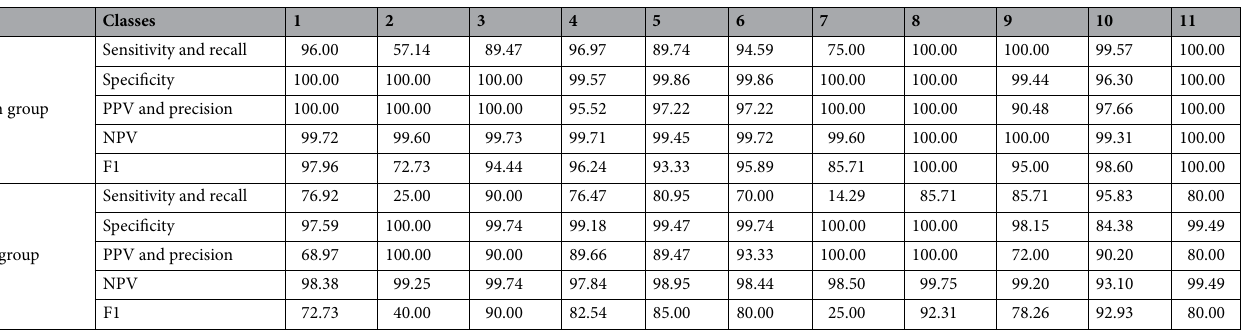
Table 3. Effects of AI prediction between train and test groups among various diseases in Project 1 (%). 1: Other congenital malformations of skin; 2: Gonococcal infection; 3. Other dermatitis; 4. Unspecified viral